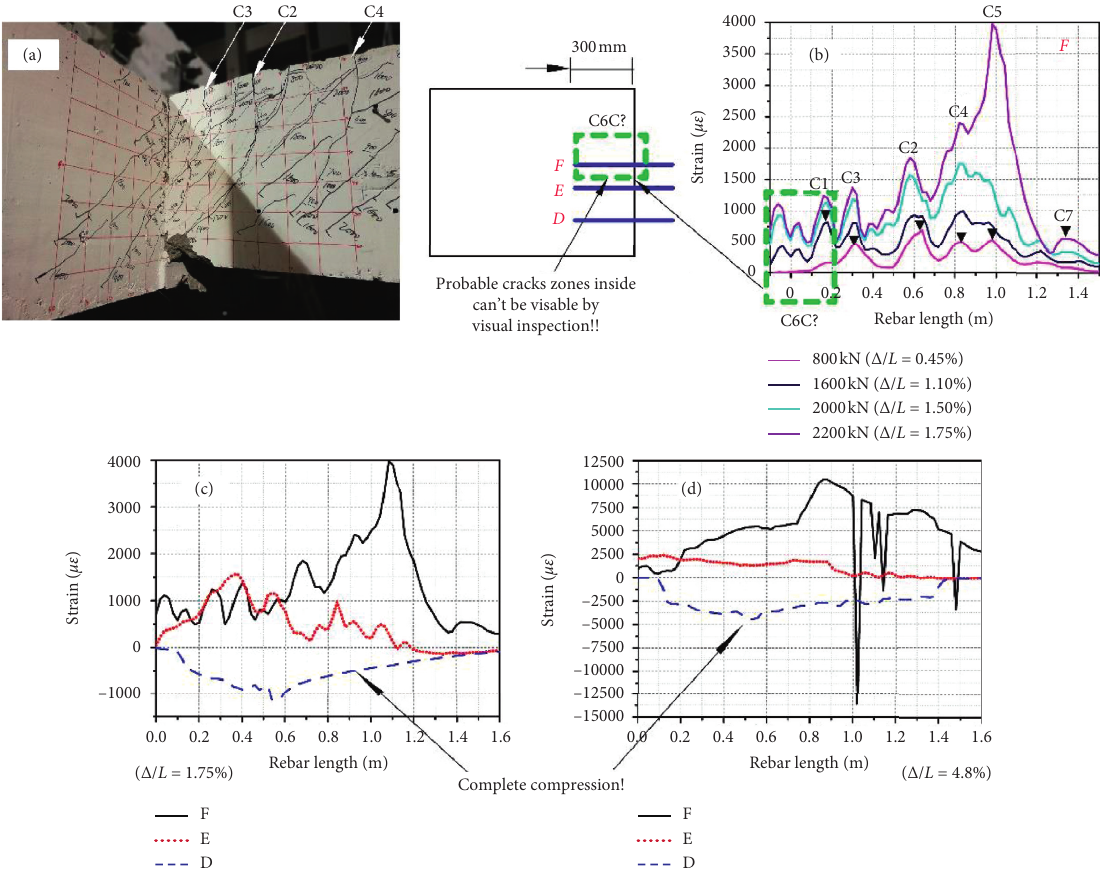
Figure 11: Damage status at 5.4% drift at side view (a), strain profile measured on side steel bar F at drift levels below 1.75% (b), and strain profile measured on side steel bars D, E, and F at 1.75% and 4.8% drift levels (c,